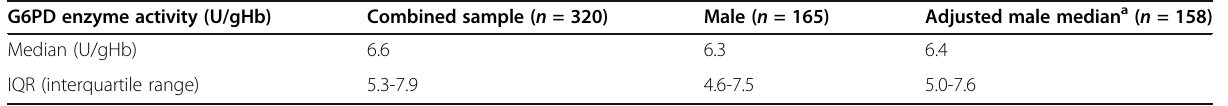
Table 2 G6PD enzyme activity determined by Biosensor among males in the combined sample of two national groups, Myanmar